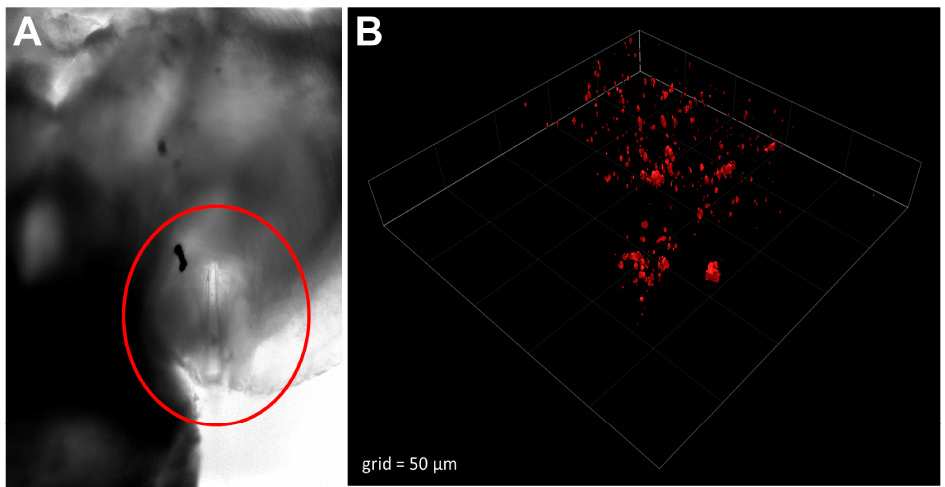
Figure 4. Bionanoprobes were precisely injected into living zebrafish brain. ( A ), Brightfield image of injection capillary (circled) inserted into the hypothalamus. ( B ), Three-dimensional rendering of a 2PE microscopy image of bionanoprobes.